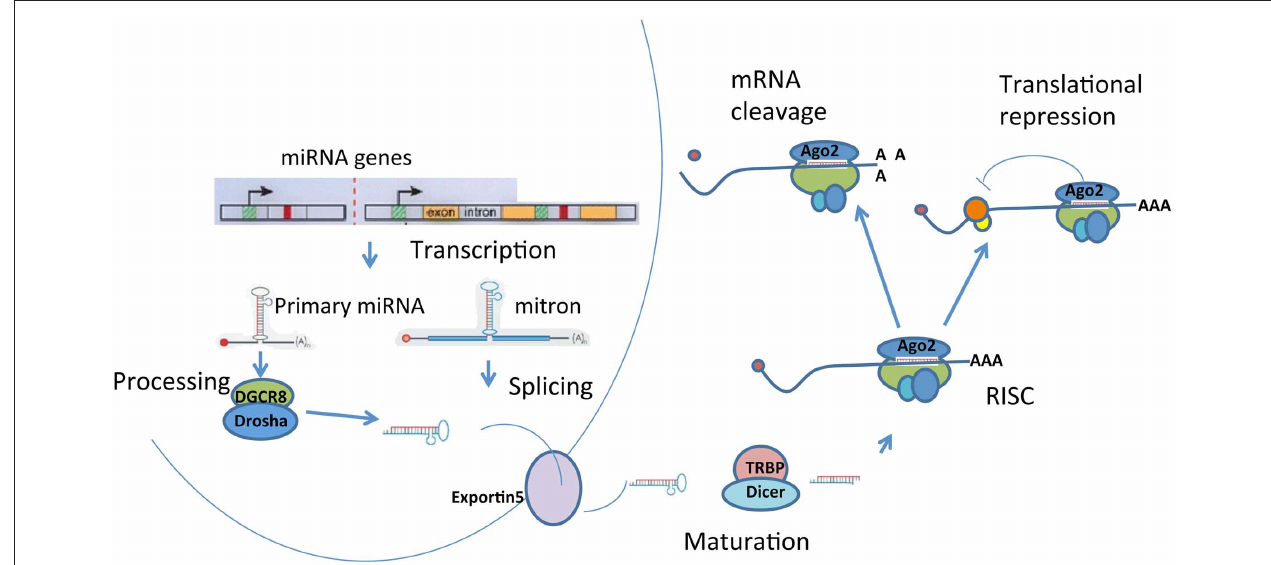
FIGURE 2 | Biogenesis of miRNAs. miRNAs are processed from precursor molecules, which are either transcripts from independent miRNA genes (pri-miRNA) or are a portion of introns of protein coding transcripts (mitron). The precursor molecules are excised into pre-miRNA with a hairpin structure. The final processing of pre-miRNA by Dicer yields miRNA